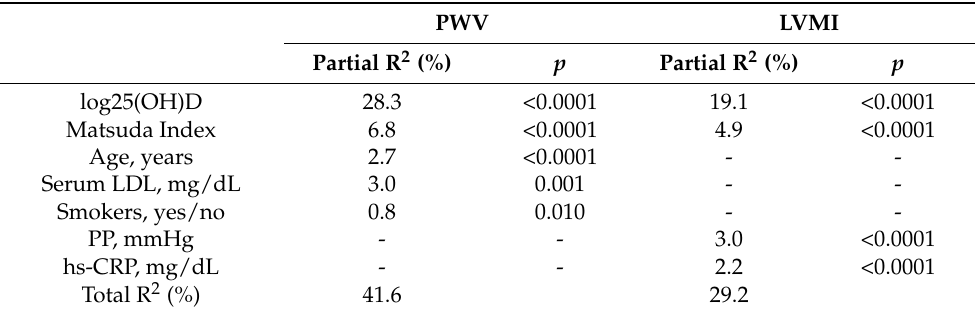
Table 3. Multiple stepwise regression analysis on pulse wave velocity (PWV) and left ventricular mass index (LVMI) as dependent